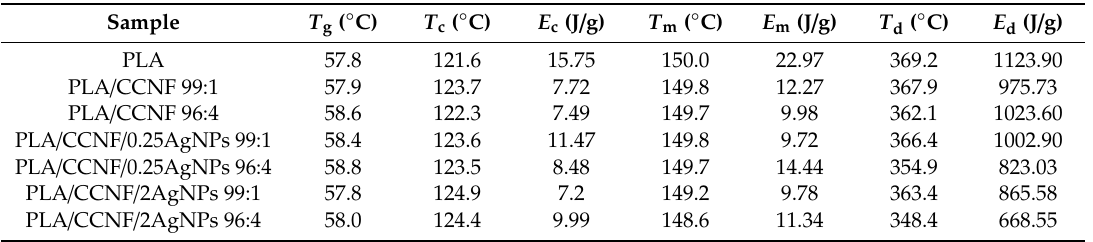
Table 2. Thermal characteristics of neat PLA and PLA reinforced with CCNF, CCNF / 0.25AgNPs, and CCNF / 2AgNPs obtained from DSC